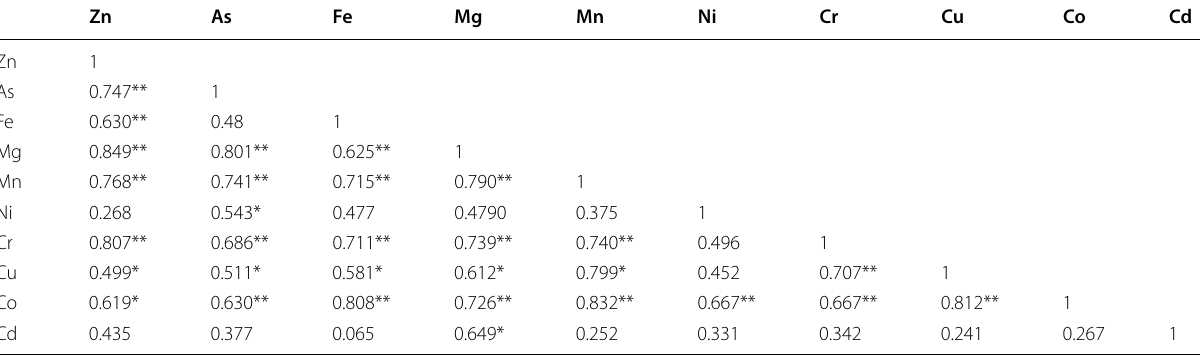
**Correlation is significant at the 0.01 level (2-tailed) *Correlation is significant at the 0.05 level (2-tailed) Computed values were for all the selected study sites